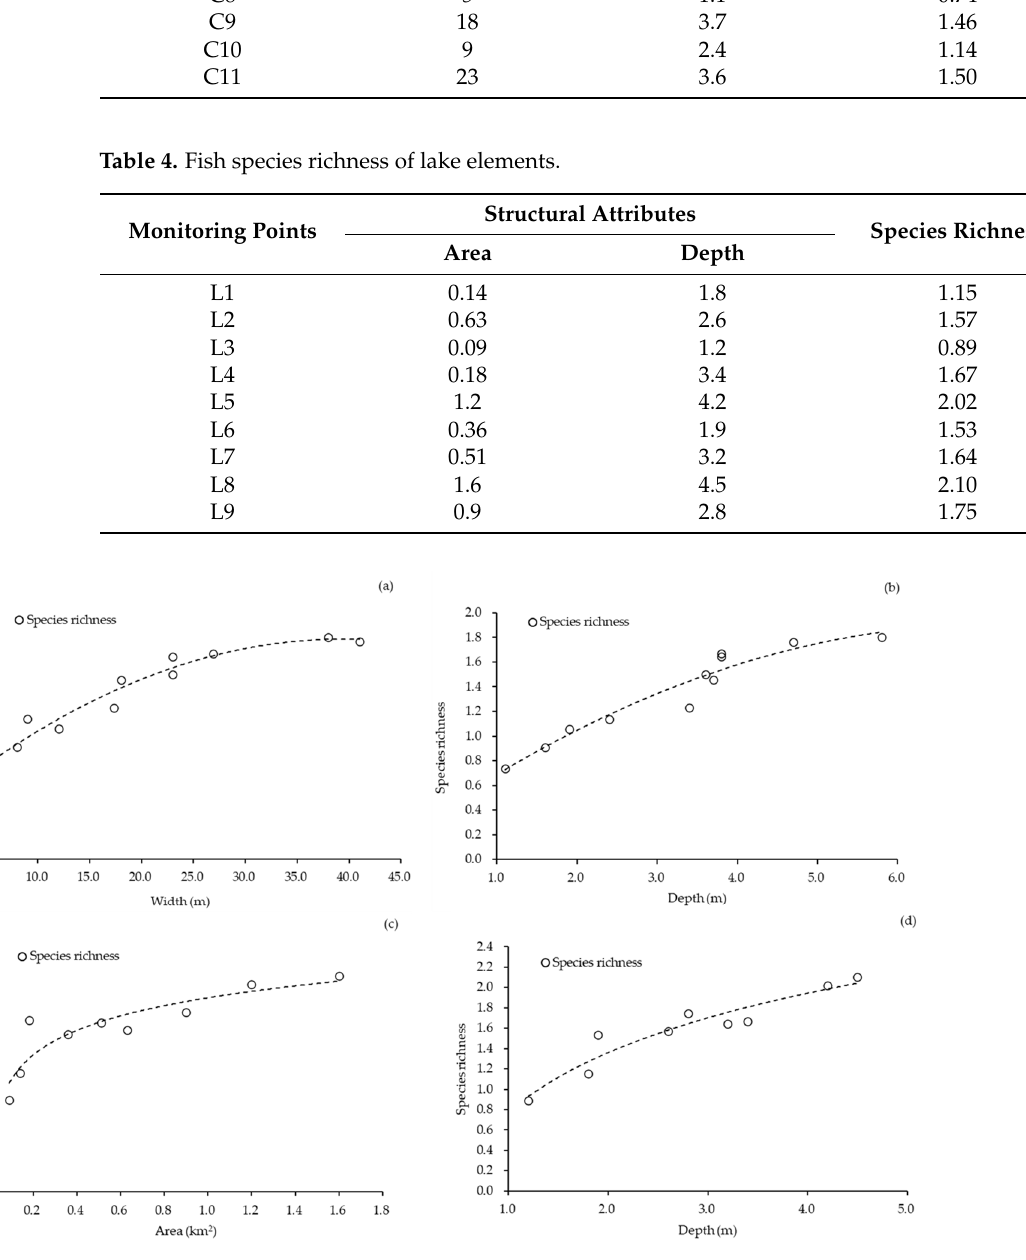
Figure 5. Relationships between structural attributes of elements and species richness. ( a , b ) is the fitting relationship between channel width, depth; ( c , d ) is the fitting relationship between lake area and depth and fish species richness.